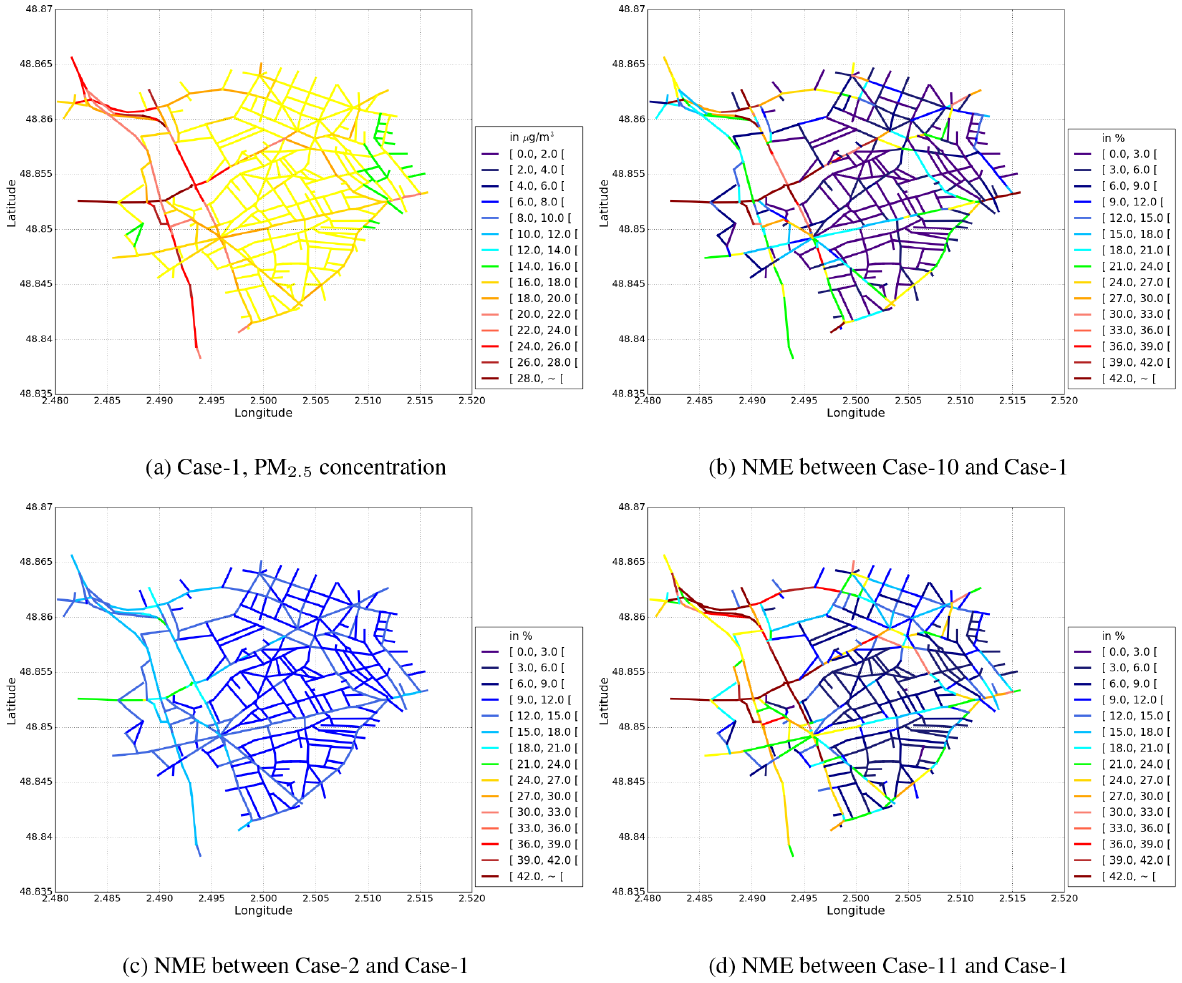
Figure 6. PM 2 . 5 time-averaged concentrations (in µgm − 3 ) for the reference test case (Case-1, a ). Normalised mean error (NME, %) between sensitivity test cases (Case-10 in b , Case-2 in c , and Case-11 in d ) and the reference test case, which quantifies the average impact of parameterisations on the concentrations. The absolute differences in concentrations between the simulations are presented in additional figures in the Appendix C. Table 4. List of test cases and normalised mean errors (NMEs, see Appendix A) between the sensitivity test cases and the reference simulation (Case-1). The NME is computed for PM 2 . 5 and NO 2 for each street over the whole simulation period and then averaged over the whole simulation